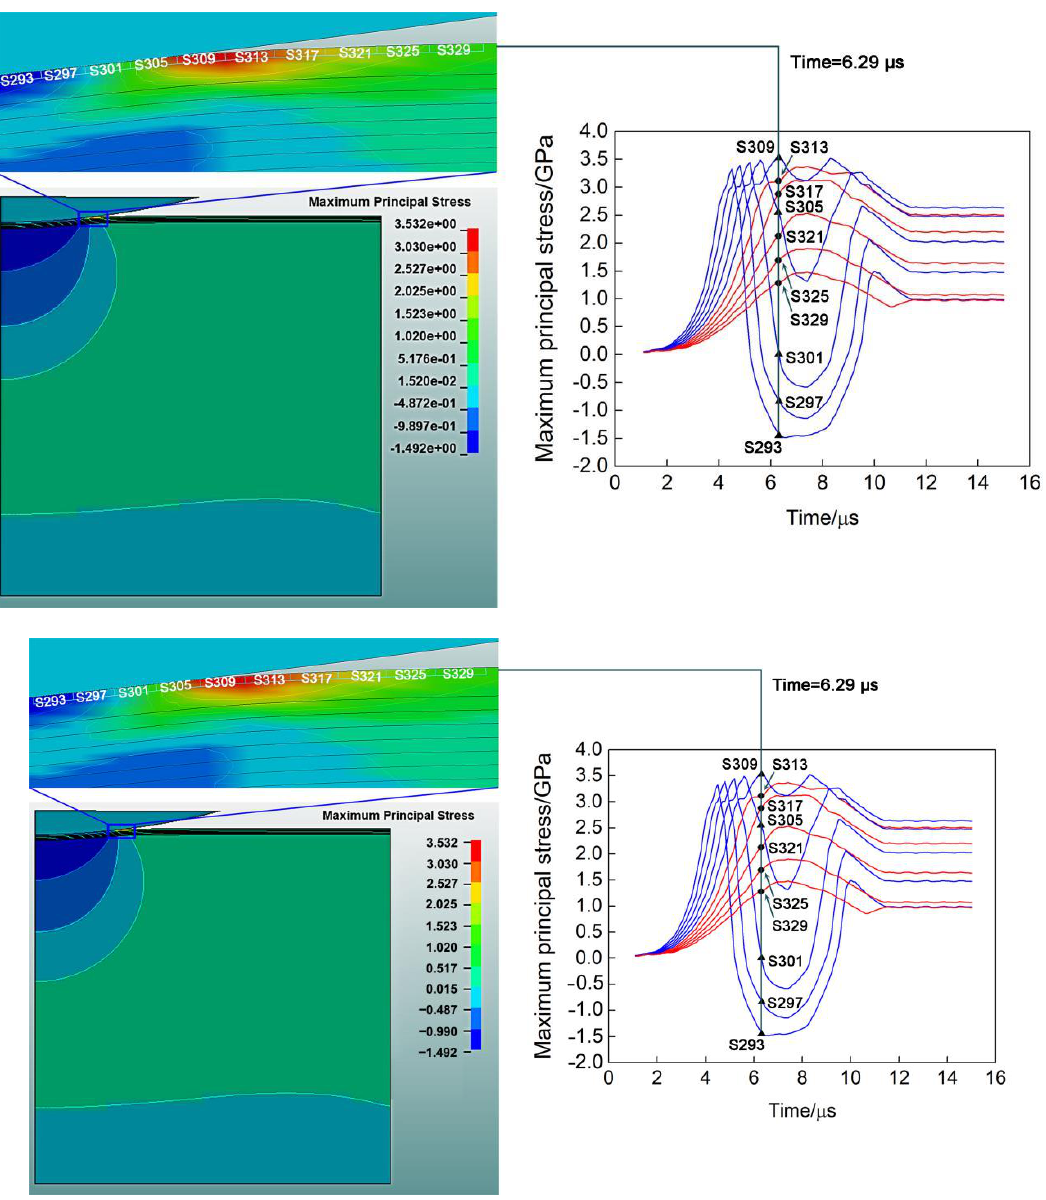
Figure 11. Maximum principal stress distributions in the Mo modified TC4 corresponding to the first 300 N